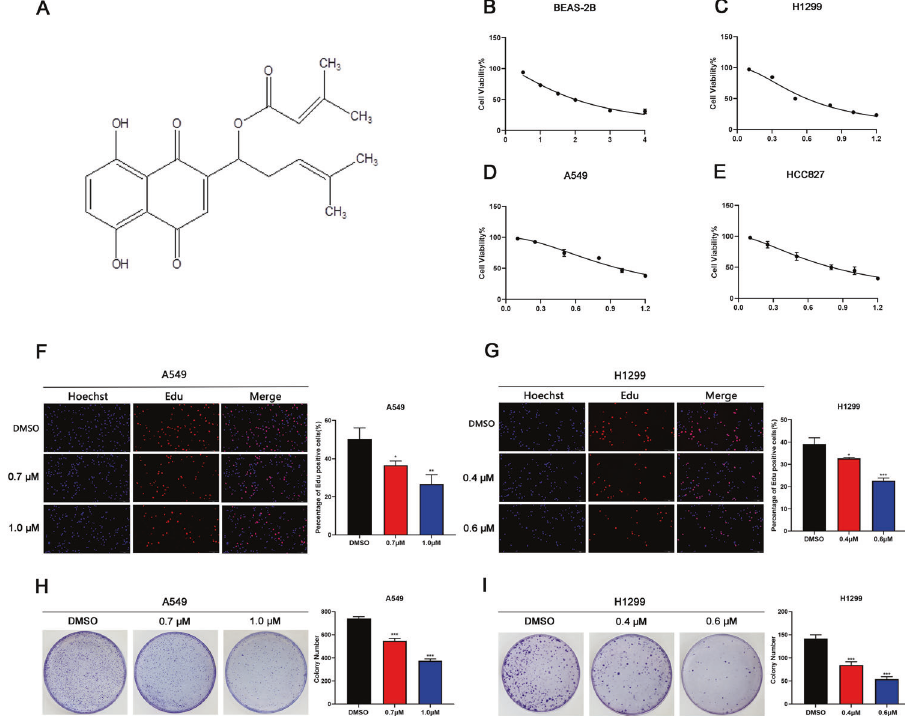
Fig. 1 ALCAP2 inhibits the proliferation of LUAD cells. A Chemical structure of ALCAP2. B – E The viability of A549, H1299, and HCC827 cells and bronchial epithelial BEAS-2B cells was determined by MTT assay after the cells treated with ALCAP2 at the indicated concentrations.